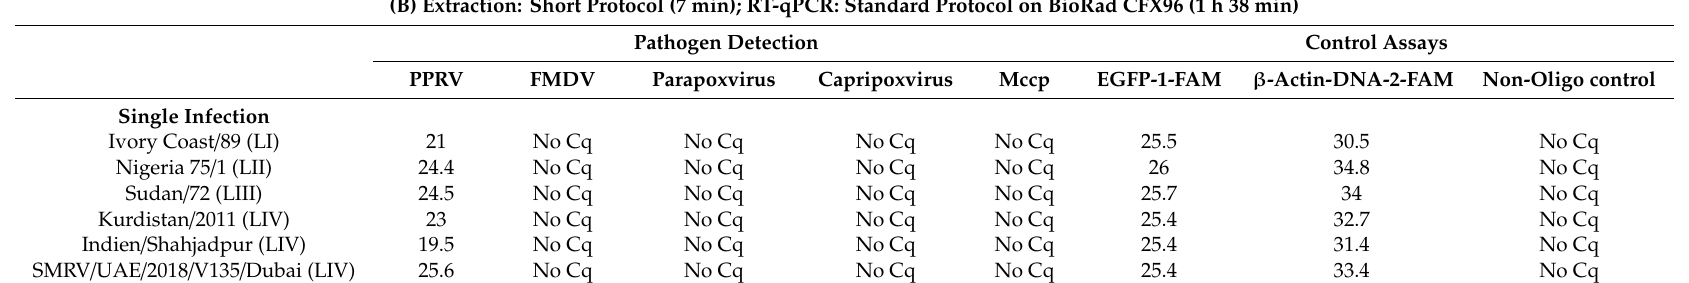
(B) Extraction: Short Protocol (7 min); RT-qPCR: Standard Protocol on BioRad CFX96 (1 h 38